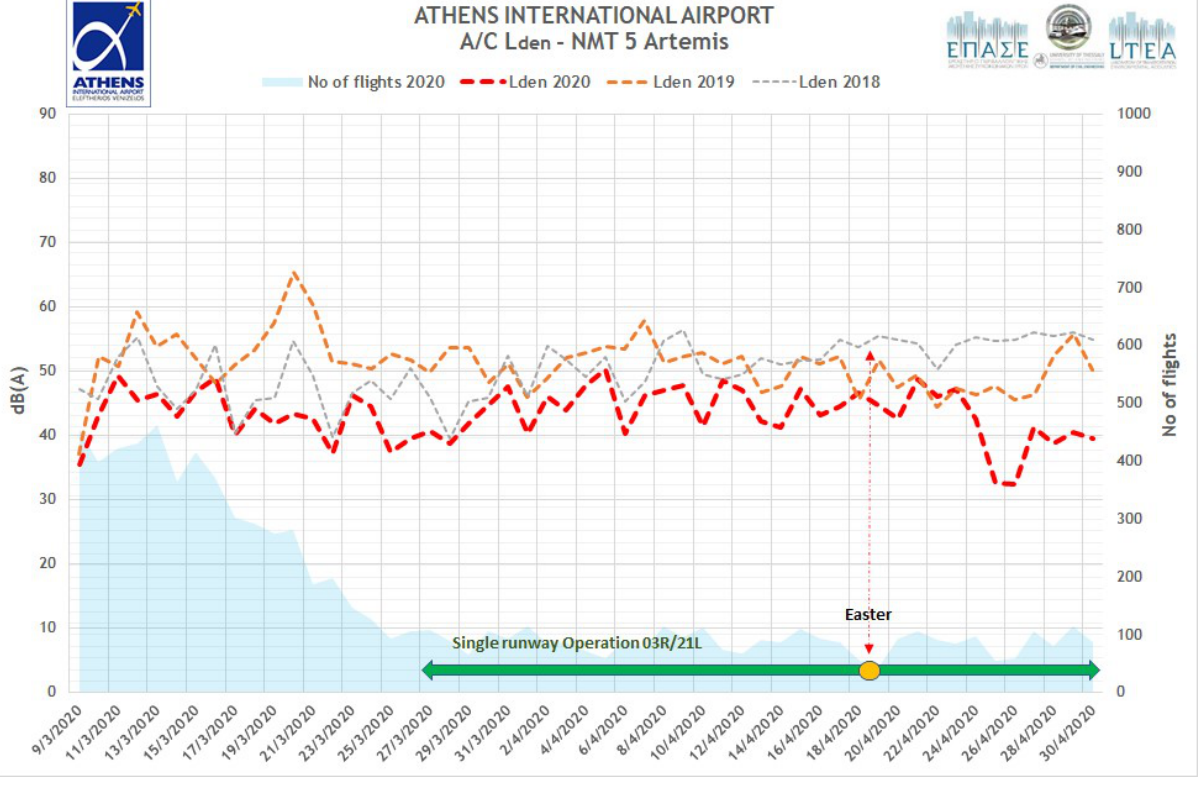
Figure 11d: Fluctuation of L den index – Noise monitoring station NMT 5